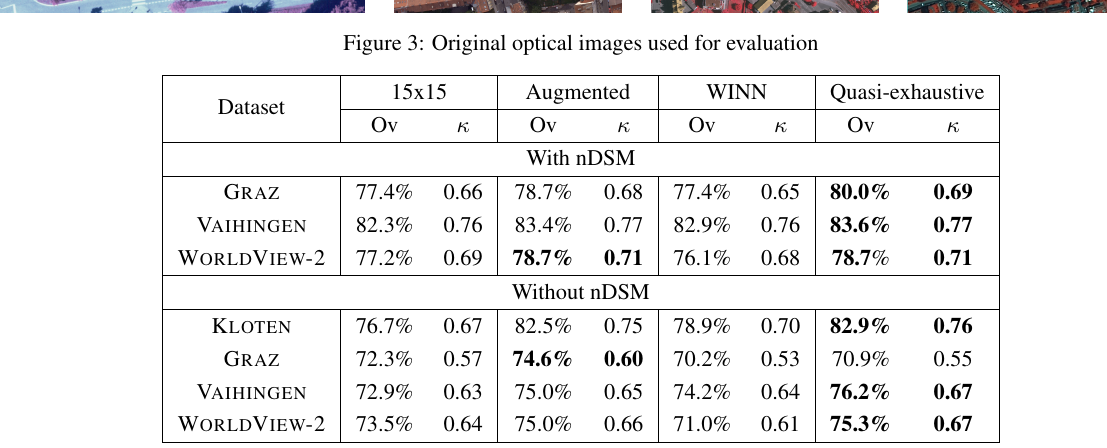
Table 1: Overall classification accuracies and kappa index for all four datasets and four feature